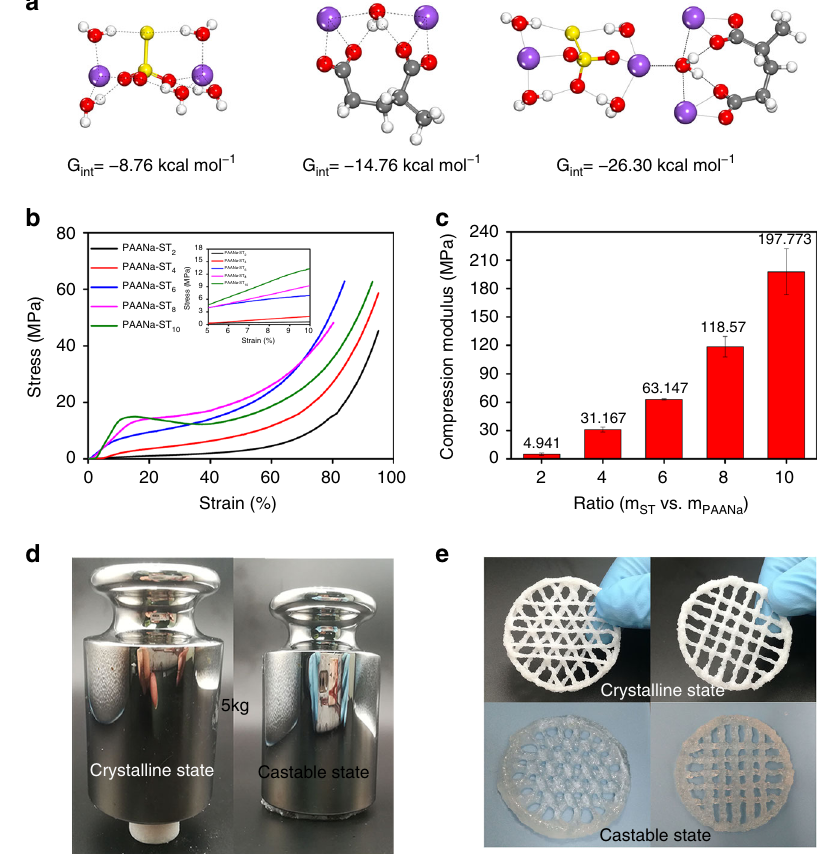
Fig. 2 Mechanical properties of composite materials. a Relative free energies at 328 K of the water in ST versus that in PAANa and interaction energy between ST and PAANa at 298 K. b Compressive curves of the composites with different mass ratios of ST in crystalline state. c Compression modulus of the composites with different mass ratios of ST in the crystalline state. d Hardness comparison of the composites in the castable and crystalline states. e Optical image of 3D printed